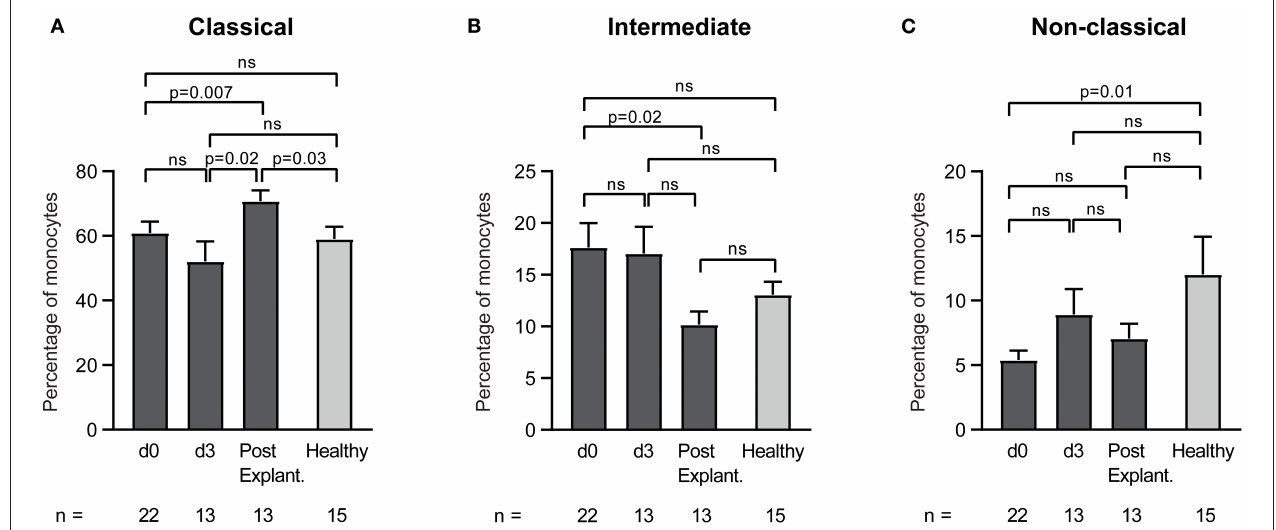
FIGURE 5 | Distribution of monocyte subsets in patients receiving veno-arterial extracorporeal membrane oxygenation on different days (d0, d3) and after explantation (post explant.) compared to healthy controls. The percentage of classical (A) , intermediate (B) , and non-classical (C) monocytes is presented. The number of remaining patients at every time point is indicated below. Data are presented as mean ± SEM. Mixed effects models were used to analyze differences between means across different time points (d0, d3, and post explantation vs. each other). Unpaired t -tests were used to analyze differences of means at single time